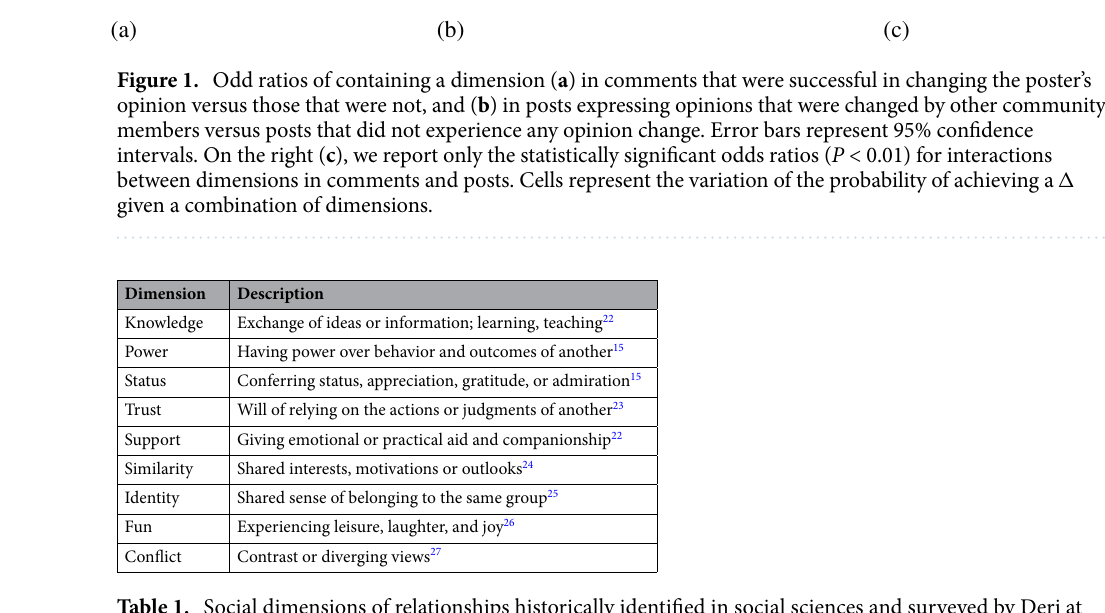
Table 1. Social dimensions of relationships historically identified in social sciences and surveyed by Deri at al. 17